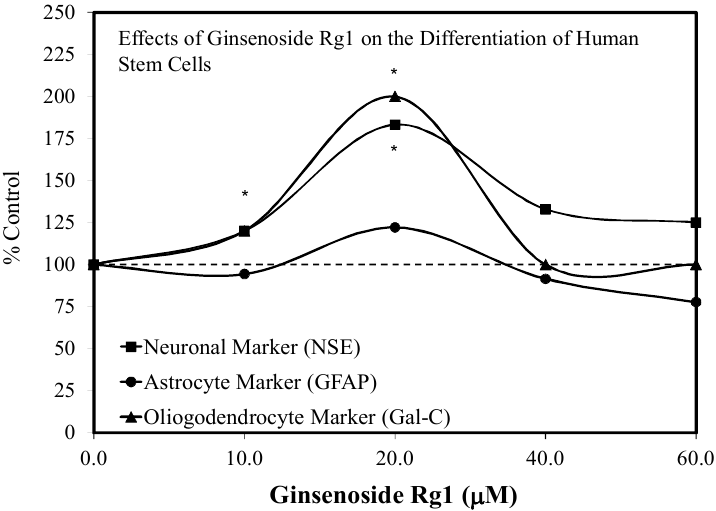
Figure 9. Effects of ginsenoside Rg1 on the differentiation of human stem cells (source: [39]). Each * Each * represent statistical significance for a data represent statistical significance for a data point.